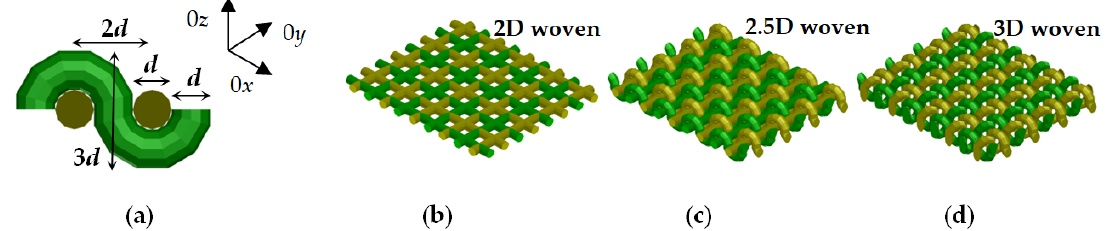
Figure 6. ( a ) Woven threads of corresponding dimensions; three types of woven fabrics: ( b ) 2D woven; straight threads along 0 x , 0 y ; ( c ) 2.5D woven; straight threads along 0 y , wavy threads along 0 x ; ( d ) 3D woven; wavy threads along 0 x , 0 y (all threads are with equal dielectric constant ε thread = 3.4).